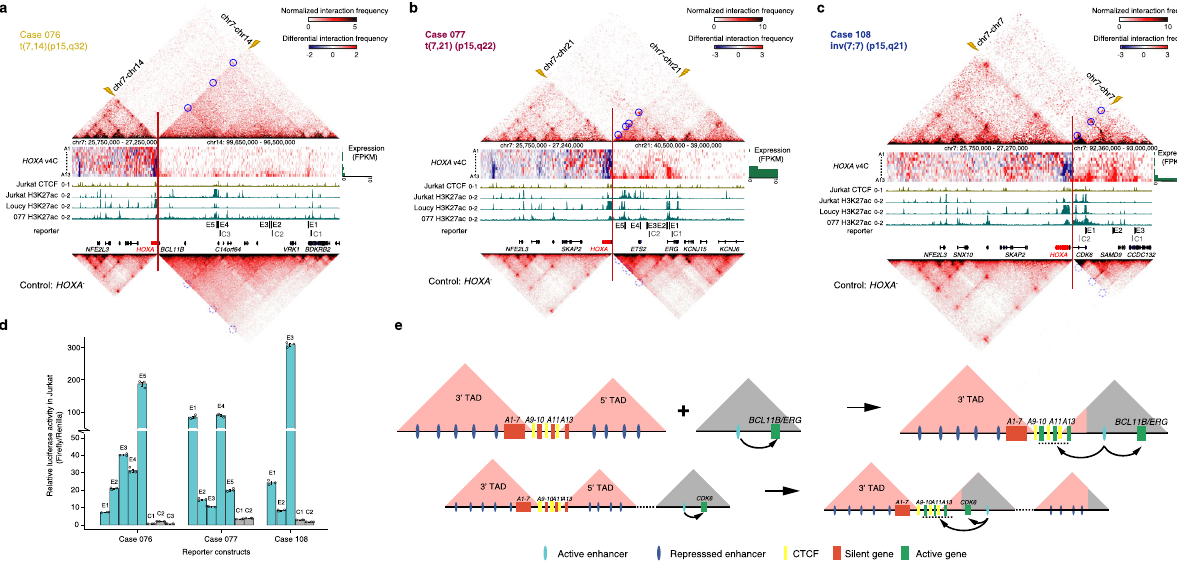
Fig. 5 Translocation-mediated enhancer hijacking and ectopic HOXA gene expressions in T-ALLs. a – c Individual Hi-C heatmaps for three HOXA13 -T cases (top) and averaged Hi-C heatmaps of HOXA − control cases (bottom). Middle panels are differential visual 4C plots between HOXA13 -T cases and HOXA − using HOXA1-A13 genes (from top to bottom) as the viewpoint. ChIP-seq tracks of CTCF of Jurkat and H3K27ac of Jurkat, Loucy, and case 077 are also included. The green bar graphs on the right show the expression level of each HOXA gene. Breakpoints are marked by the red lines and yellow lightning bolts. Translocation-mediated loops are highlighted by blue circles, corresponding locations in control samples are marked by dotted circles. Location of predicted enhancers and control regions are marked by black and gray bars, respectively. d Luciferase reporter activity for regions encompassed within the predicted enhancers and control regions indicated in a – c compared to empty vector in Jurkat cell line ( n = 3 per group). Data are represented as mean ± SD. e Schematic illustrations of the consequences of HOXA13 -related translocations (upper) and inversion